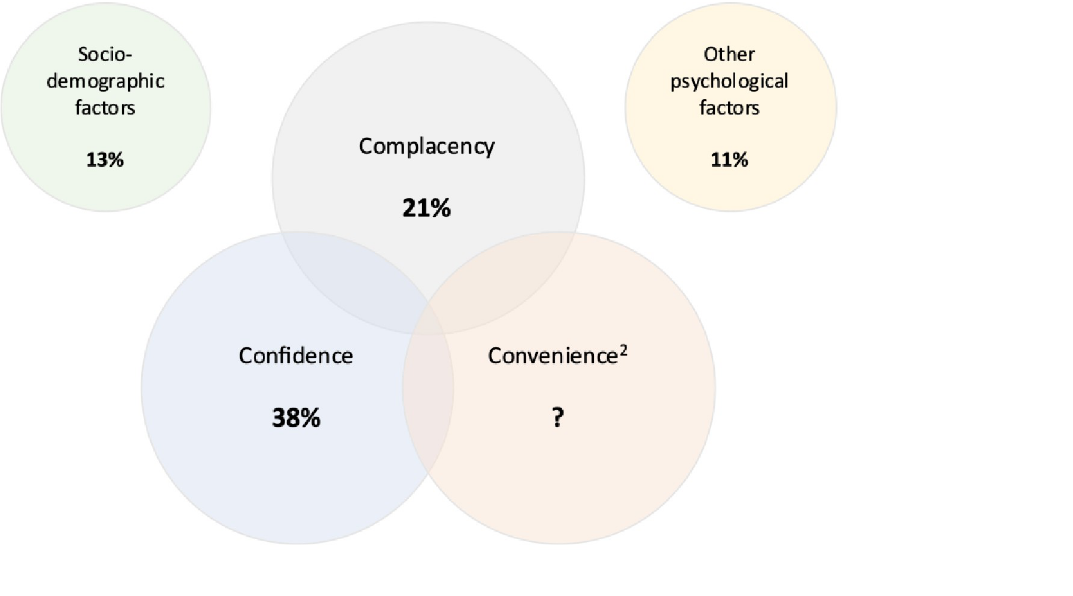
Fig 3. Variance of COVID-19 vaccine hesitancy explained by vaccine confidence, vaccine complacency, sociodemographic, and other psychological factors 1 .